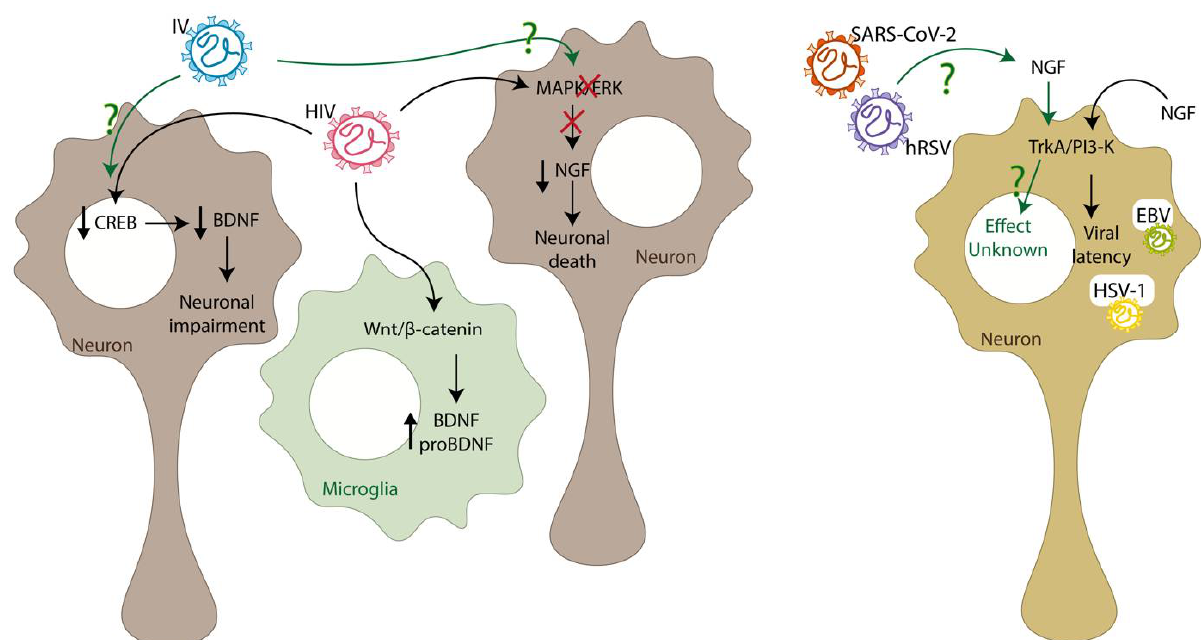
Figure 2. Viruses interfere with the normal signaling pathways of neurotrophins. The human immunodeficiency virus (HIV) can promote the increment of both proBDNF and mature BDNF in microglial cells. Additionally, HIV can downregulate the CREB pathway, decreasing the levels of BDNF and causing neuronal impairment. Finally, HIV can interfere with the MAPK/ERK pathway, decreasing the NGF levels and inducing neuronal death. The influenza virus (IV) lowers both BDNF and NGF levels. However, the pathway that alters to cause this effect has not been described. Regarding Epstein Barr virus (EBV) and herpes simplex virus-1 (HSV-1), their viral latency is induced by activating the PI3-K pathway activated by the NGF/TrkA association. Lastly, in the case of human respiratory syncytial virus (hRSV) and severe acute respiratory syndrome coronavirus 2 (SARS-CoV-2), it is known that they increase the levels of NGF and its high-affinity receptor TrkA. However, the effect that this interaction has remains unknown.